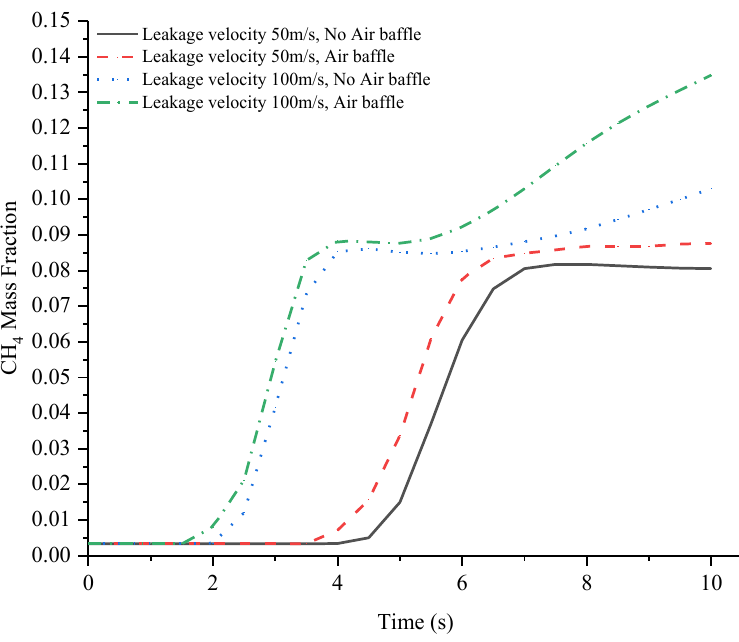
Figure 4. CH 4 concentration at detection points versus time under unventilated conditions.